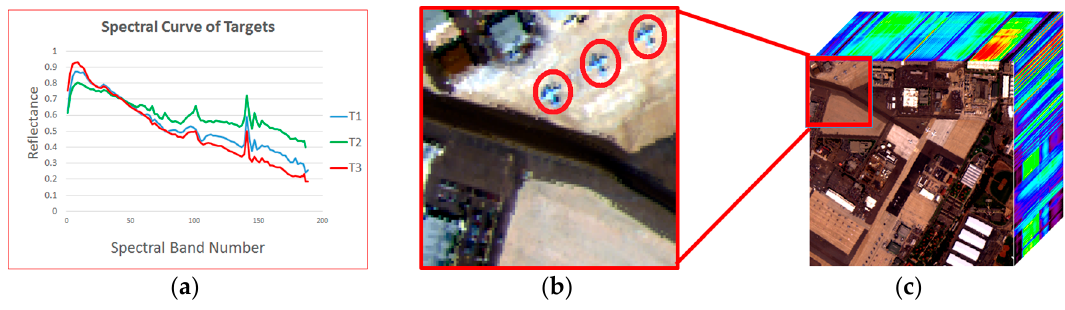
Figure 4. San Diego real dataset: ( a ) the spectral curve of targets; ( b ) the location of targets in selected subset; and, ( c ) the original data.